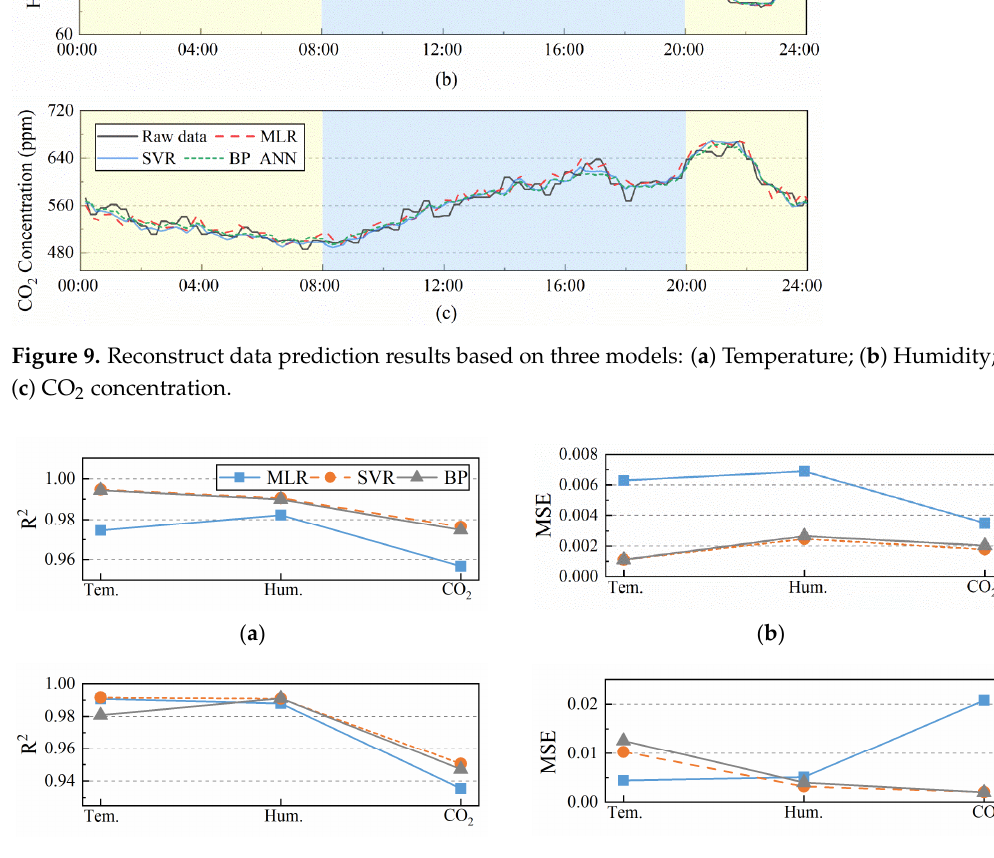
Figure 10. Performance analysis of three models: ( a ) Comparison of R 2 of the three algorithms in the training set; ( b ) Comparison of MSE of the three algorithms in the training set; ( c ) Comparison of R 2 of the three algorithms in the test set; ( d ) Comparison of MSE of the three algorithms in the test set.